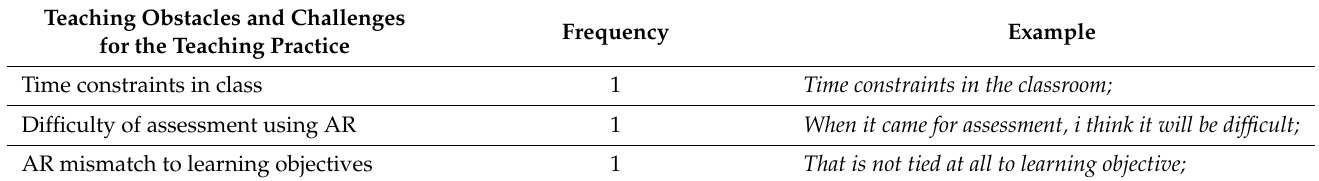
Table 15. Teaching’s obstacles and challenges in integrating ARinE.